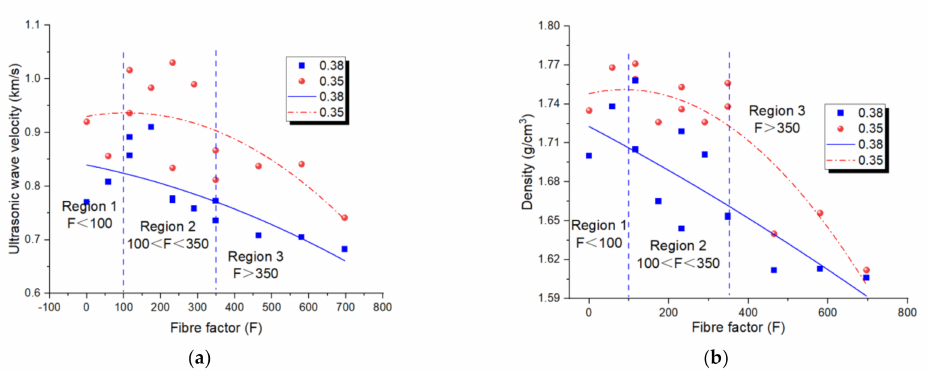
Figure 6. Relationships of ( a ) fibre factor-ultrasonic wave velocity; ( b ) fibre factor-density of PP fibre-reinforced